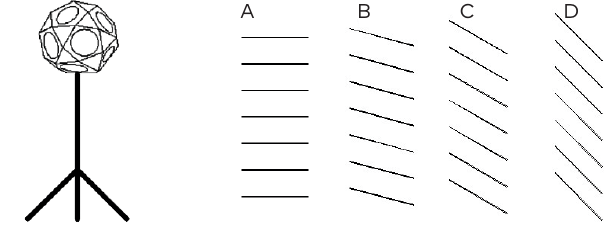
Figure 4. Tilting positions of louvred barrier blades in